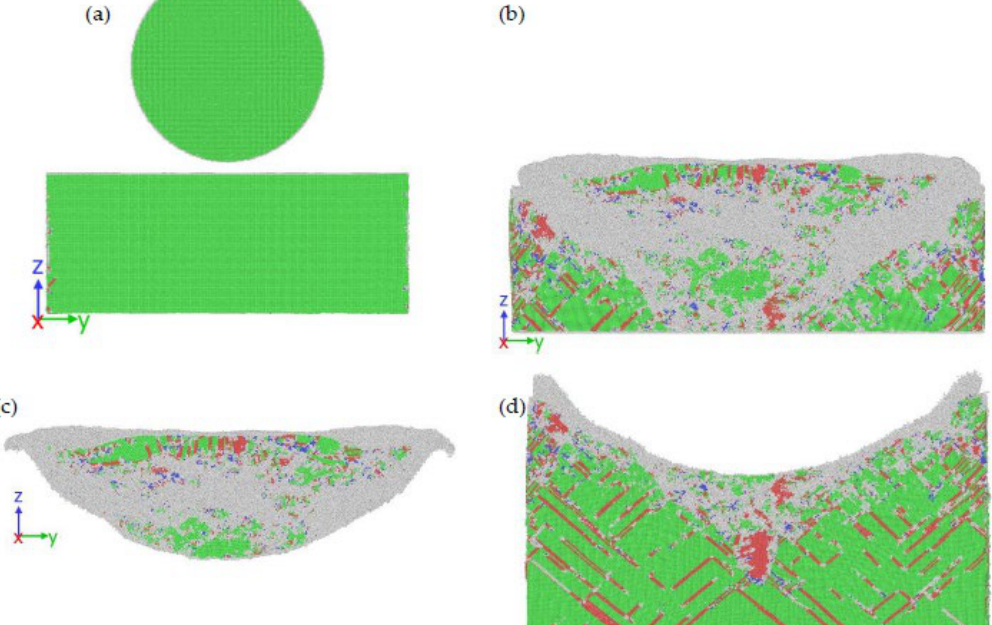
Figure 14. Microstructural snapshots presenting a structural transformation ( a ) at 0 ps ( b ) at 20 ps of a cold gas dynamic spray splat at 1500 m/s ( c ) splat microstructure at 20 ps ( d ) substrate microstructure at 20 ps. Structural transformation at the interfacial zone between the substrate and particle after impact is evident here.